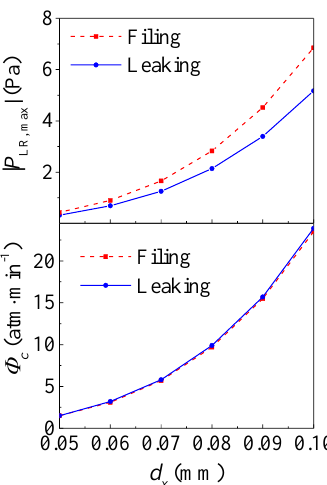
Figure 10. Effect of the diameter of the microcapillary fill tube d x on the critical pressure variation rate Φ c and the maximum pressure difference across the hole on the support tent Δ P LR, max . ( d o = 0.2 mm, N s = 1, l x = 500 mm).